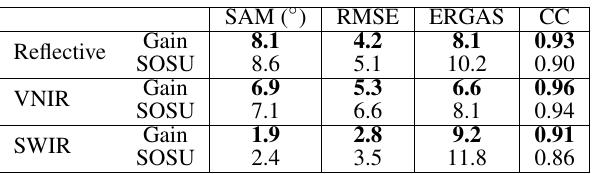
Table 1. Criteria computed on the full image